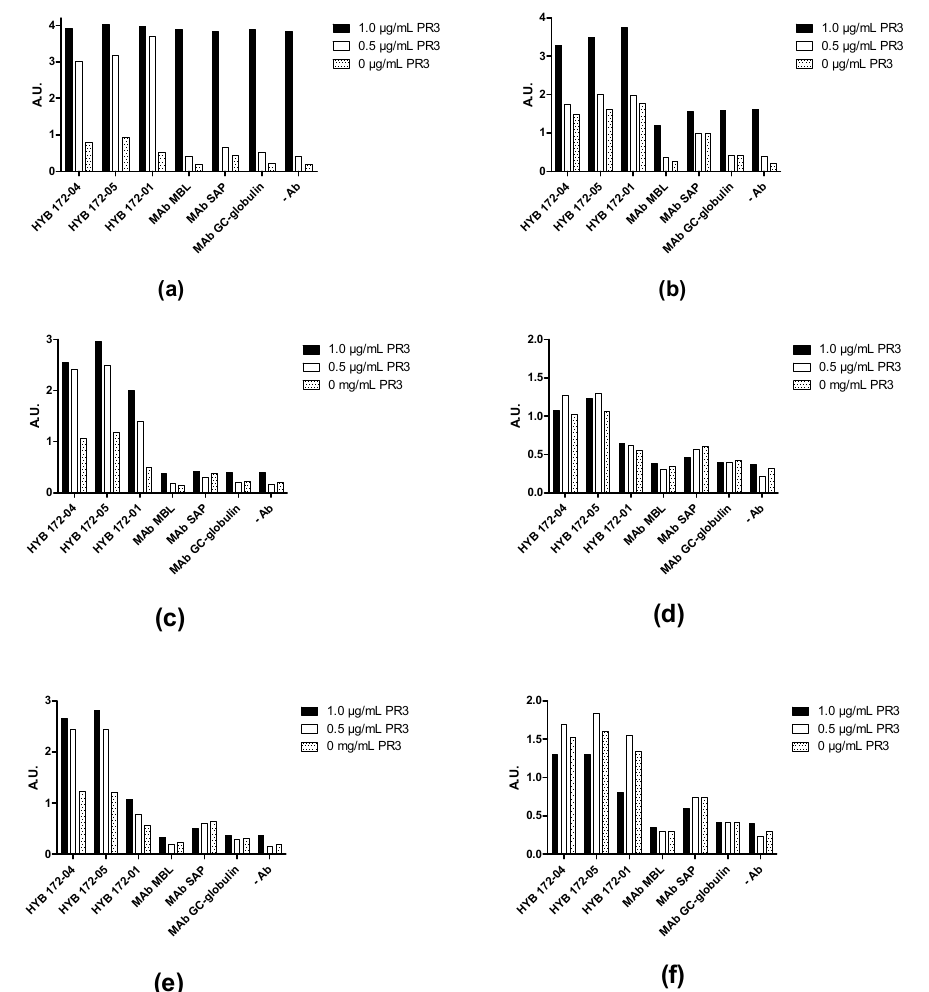
Figure 12. Screening of PR3 autoantibodies in GPA patient sera using PR3 (SSI) concentration- dependent capture ELISA. HYB 172-04, HYB 172-05, HYB 172-01 and irrelevant control MAbs were used as capture antibodies, in combination with PR3 concentrations ranging from 0–1 µg/mL. ( a – f ) illustrates the reactivity of 6 GPA PR3 AuAb-positive patients (2 strongly positive ( a , b ), 2 middle positive ( c , d ) and 2 weakly positive ( e , f )).